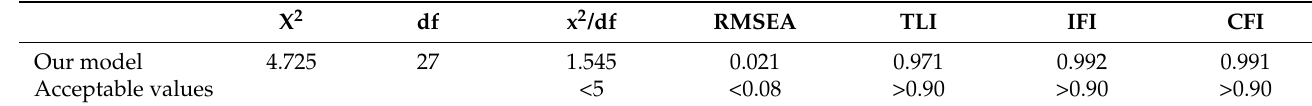
Table 4. Goodness-of-fit statistics for confirmatory factor analysis model.